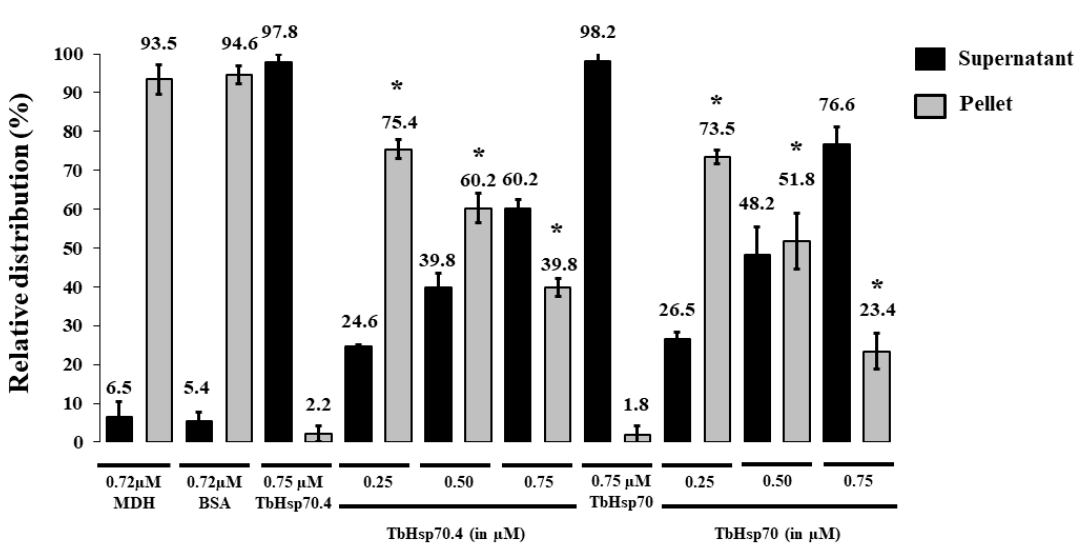
Figure A1. TbHsp70 and TbHsp70.4 suppress the thermal aggregation of MDH. The holdase function of recombinant TbHsp70 and TbHsp70.4 was conducted by monitoring the heat-induced aggregation of MDH (0.72 µ M) in vitro at 48 ◦ C and by quantifying the pellet (insoluble; grey bars) and supernatant (soluble; black bars) fractions after heat exposure. The thermal aggregation of MDH in the presence of a non-chaperone, BSA, is shown. TbHsp70.4 and TbHsp70 in the absence of MDH were not prone to aggregation under the assay conditions. Standard deviations were obtained from three replicate assays on three independent batches of purified protein. A statistically significant di ff erence between a reaction and MDH alone are indicated by * ( p < 0.05) above the reaction using a Student’s t-test.